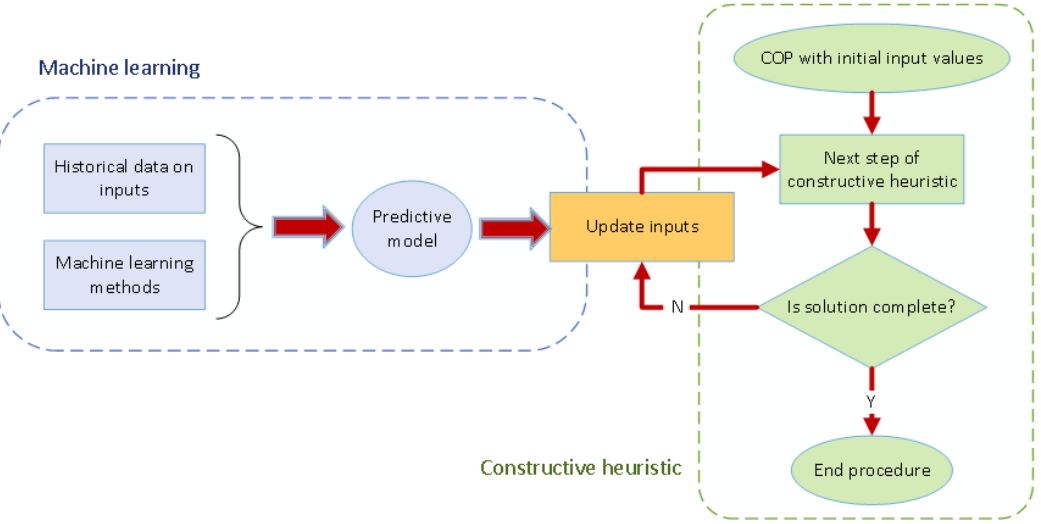
Fig. 5. Basic scheme of a learnheuristic